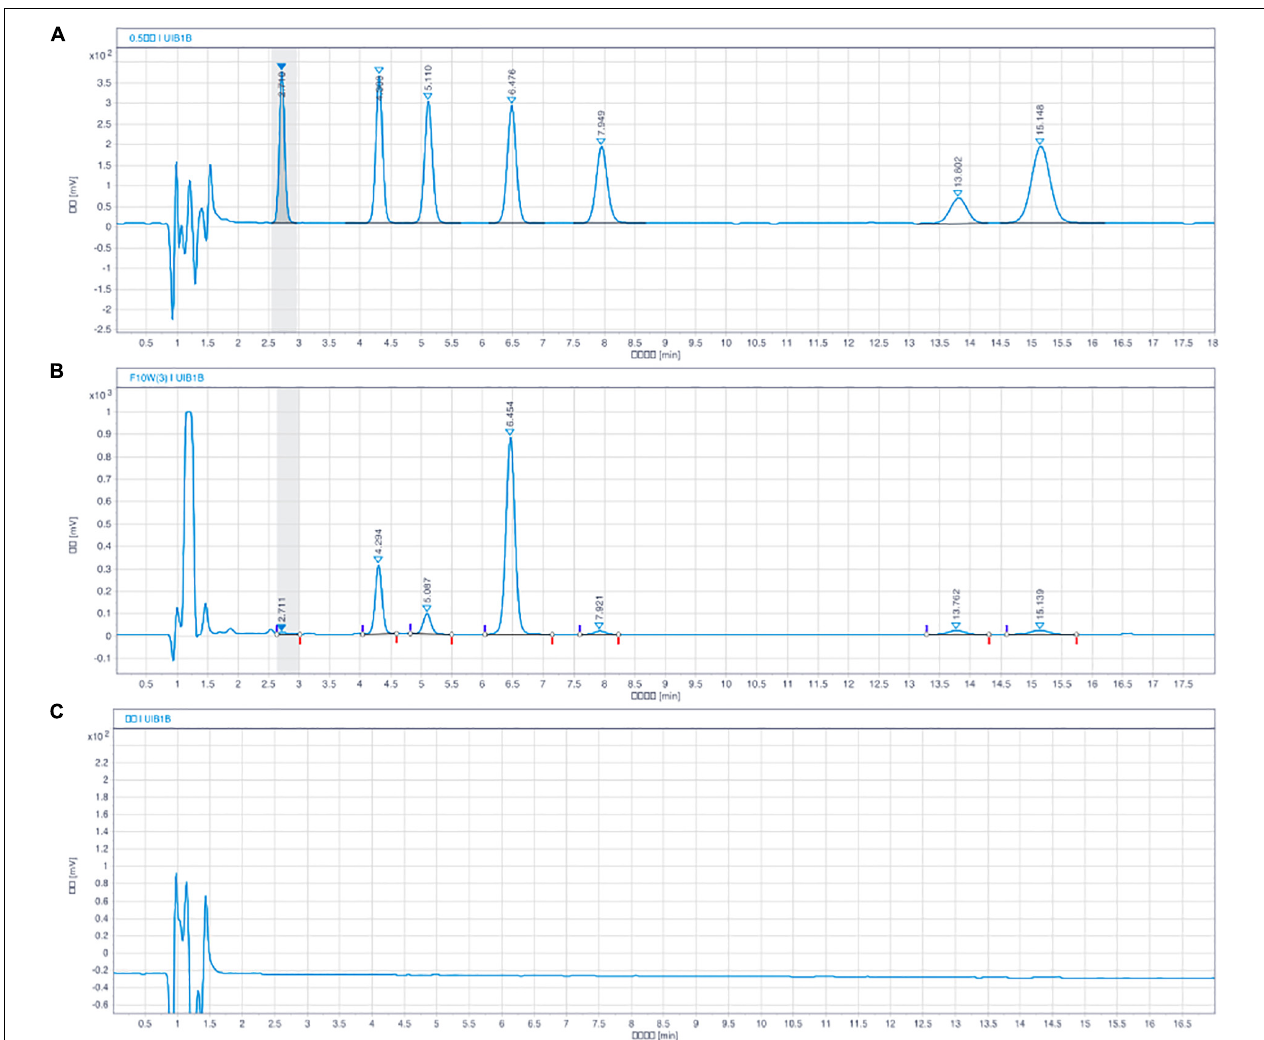
FIGURE 2 | Chromatograms of monoamine neurotransmitter with HPLC-ECD assay. NE ( t R = 2.7 min), DHBA ( t R = 4.3 min, internal standard), DOPAC ( t R = 5.1 min), DA ( t R = 6.4 min), 5-HIAA ( t R = 7.9 min), HVA ( t R = 13.5 min), 5-HT ( t R = 15.7 min). (A) Blank solution, (B) Solution of mixed standard substances, and (C) Sample solution of rat